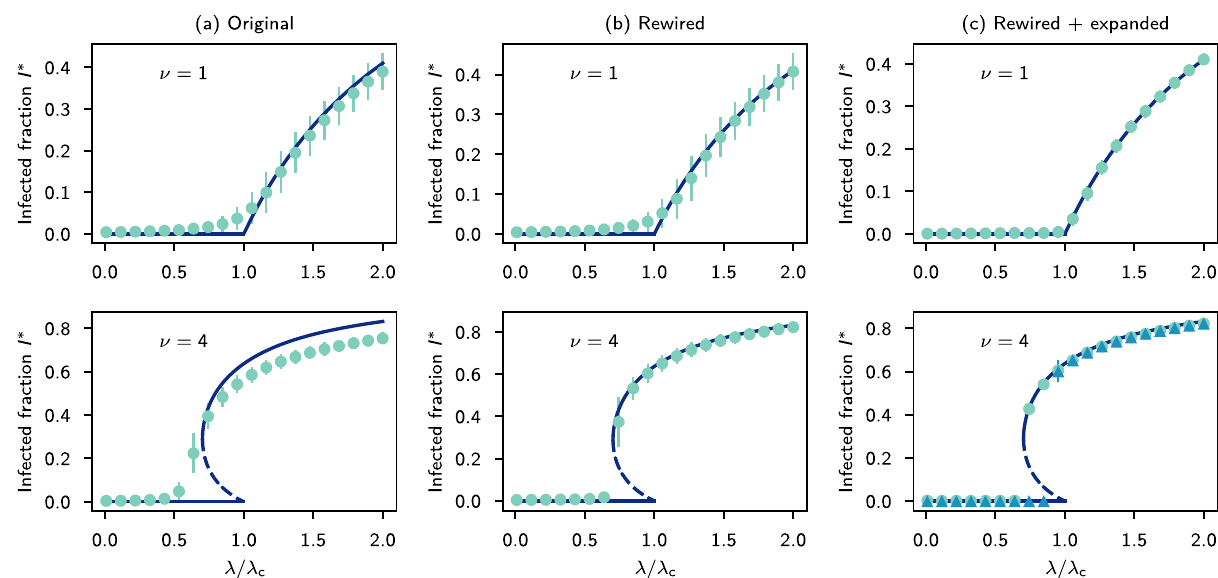
Fig. 2 Phase transition on a hypergraph constructed from high-resolution face-to-face contact data. See “ Contagion on real-world hypergraphs" in “ Methods. ” The hypergraph contains 242 nodes and 1188 groups. Both the membership and the group size distributions are homogeneous, with 〈 m 〉 ≈ 11.79, 〈 n 〉 ≈ 2.40, m max ¼ 32, and n max ¼ 5. We compare the results of Monte Carlo simulations (symbols) with the predictions of our approach (solid and dashed lines for stable and unstable solutions, respectively) for the fraction I * of infectious nodes in the stationary state. Note that in the “ Phase transition" subsection in the main text, we omit the asterisk for stationary quantities to simplify the notation. The infection rate function is β ( n , i ) = λ i ν , where ν controls the nonlinearity of the contagion. We rescale λ with the invasion threshold λ c , which is computed using Eq. (15). The symbols represent the average infected fraction measured over long runs and averaged over randomized hypergraphs when this applies. The error bars (sometimes too small to be seen) correspond to one standard deviation. The green circles are obtained with the quasistationary-state method, starting with a large fraction of infected nodes ( I = 0.8) to sample the upper branch of the hysteresis loop when the phase transition is discontinuous. We use a the original hypergraph, b 10 uniformly randomized versions of the original hypergraph, or c 10 uniformly randomized versions of the original hypergraph with its size expanded by a factor of 10, with either linear ( ν = 1) or superlinear contagion ( ν = 4). For superlinear contagion in c , the blue triangles are obtained by ordinary simulations, starting with a small fraction of infected nodes ( I = 0.02) to sample the lower branch of the hysteresis loop. We only do it for the expanded hypergraphs because fi nite-size effects make unreliable the estimation of the lower branch for small hypergraphs.